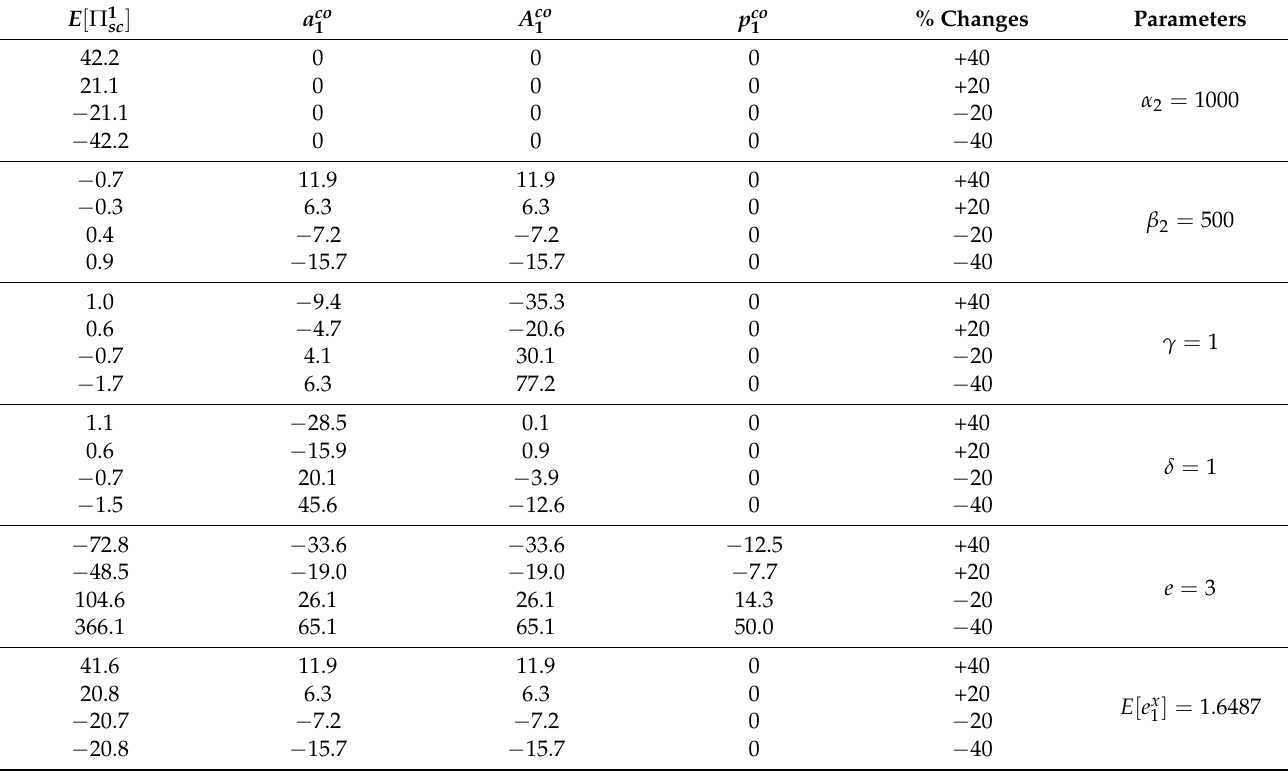
Table 10. The results of the sensitivity analysis with a cooperative game for the first model.